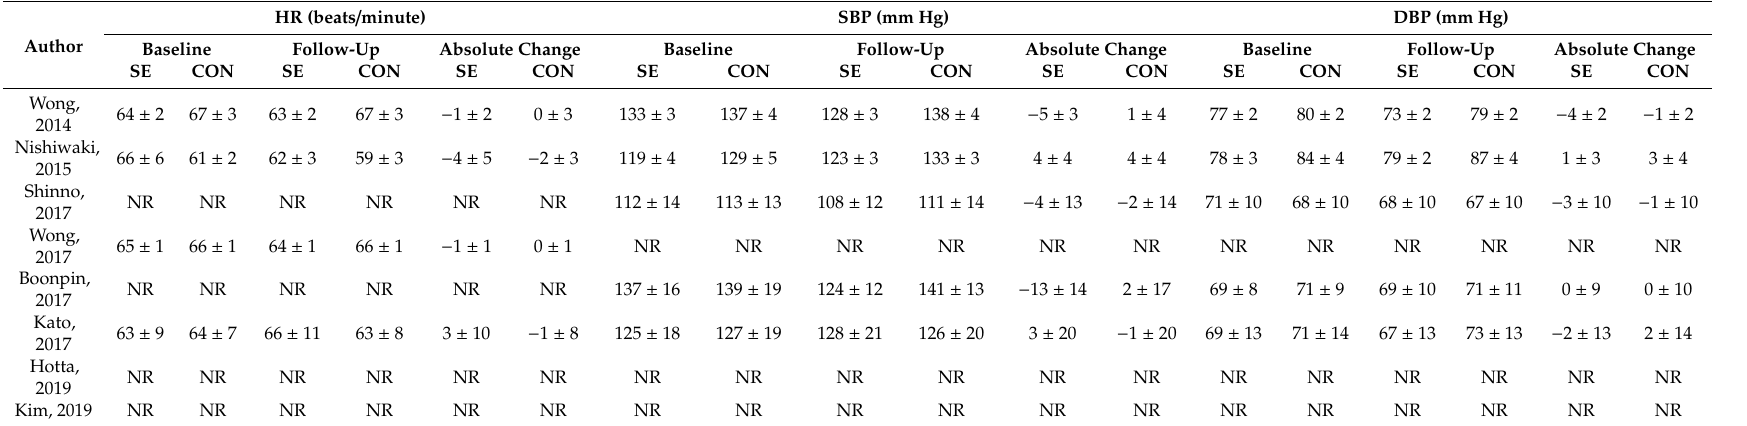
Table 4. Changes in parameters of hemodynamic